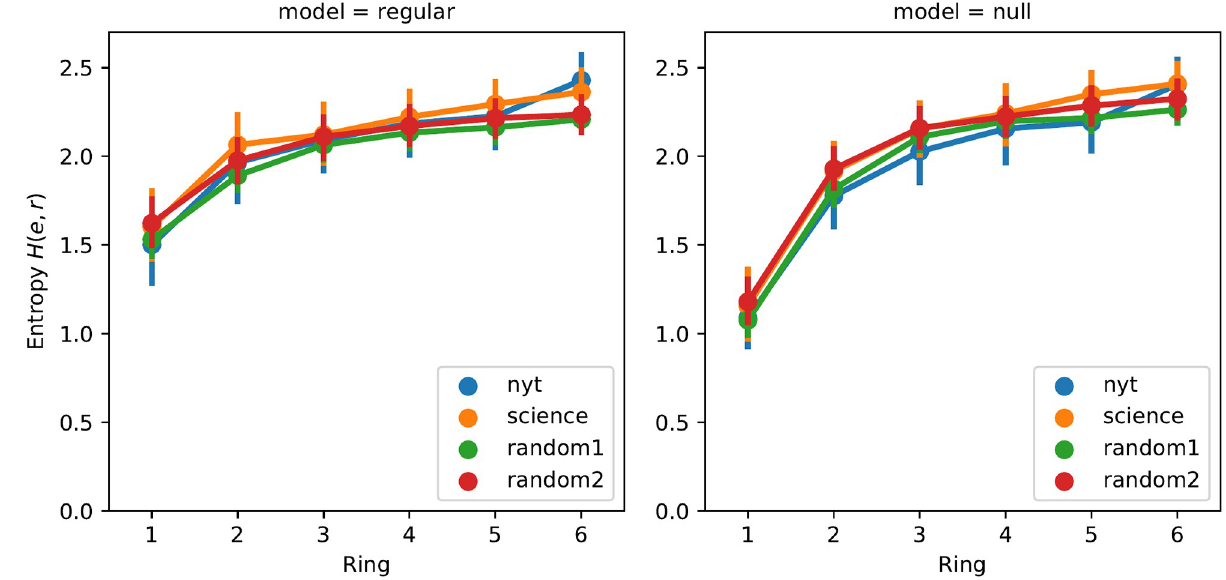
Fig 13. Entropy of the semantic profiles per ring. Real-life ego networks (left) vs null model ego networks (right).